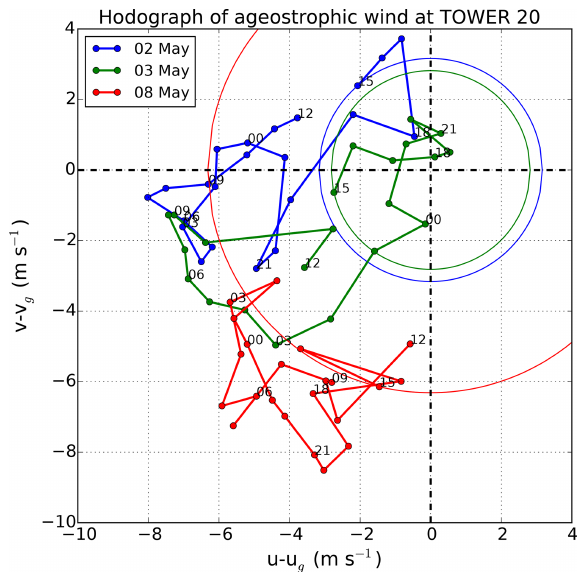
Figure 15. WRF D3 hodographs of ageostrophic wind components for three different nocturnal LLJ cases (2, 3 and 8 May 2017) at tower T20. Ageostrophic wind components correspond to differ- ences between winds at level L 1 and level L 2 . Numbers indicate the time of the day in hours. Hodographs start at 15:00UTC the day be- fore the LLJ case, respectively (e.g. at 15:00UTC on 1 May for the 2 May case). The theoretical inertial oscillations of the ageostrophic wind according to Blackadar (1957) are illustrated with circles for the respective winds at